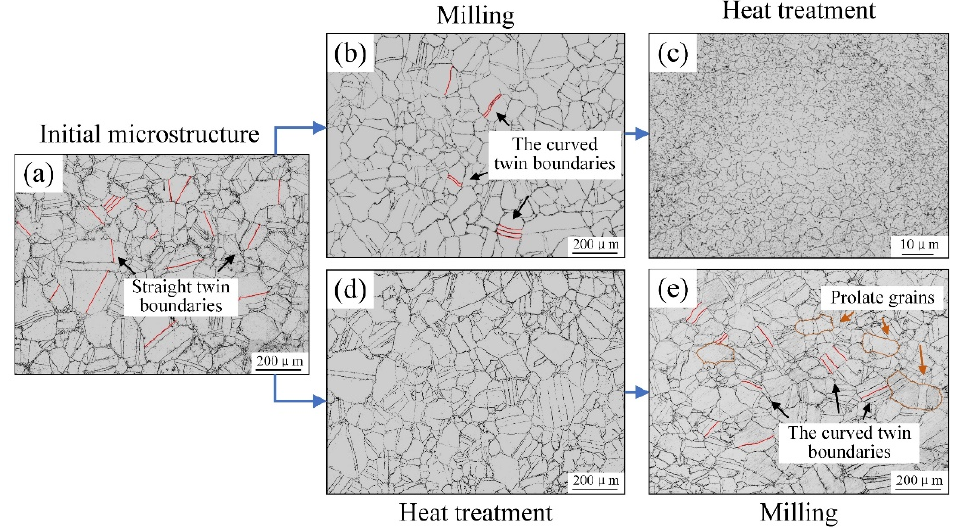
Figure 3. Surface microstructure generated in sequential production process: ( a ) initial microstructure of workpiece surface; ( b ) machined surface; ( c ) heat treated surface after machining; ( d ) heat treated surface of the as-received material; ( e ) machined surface after heat treatment.